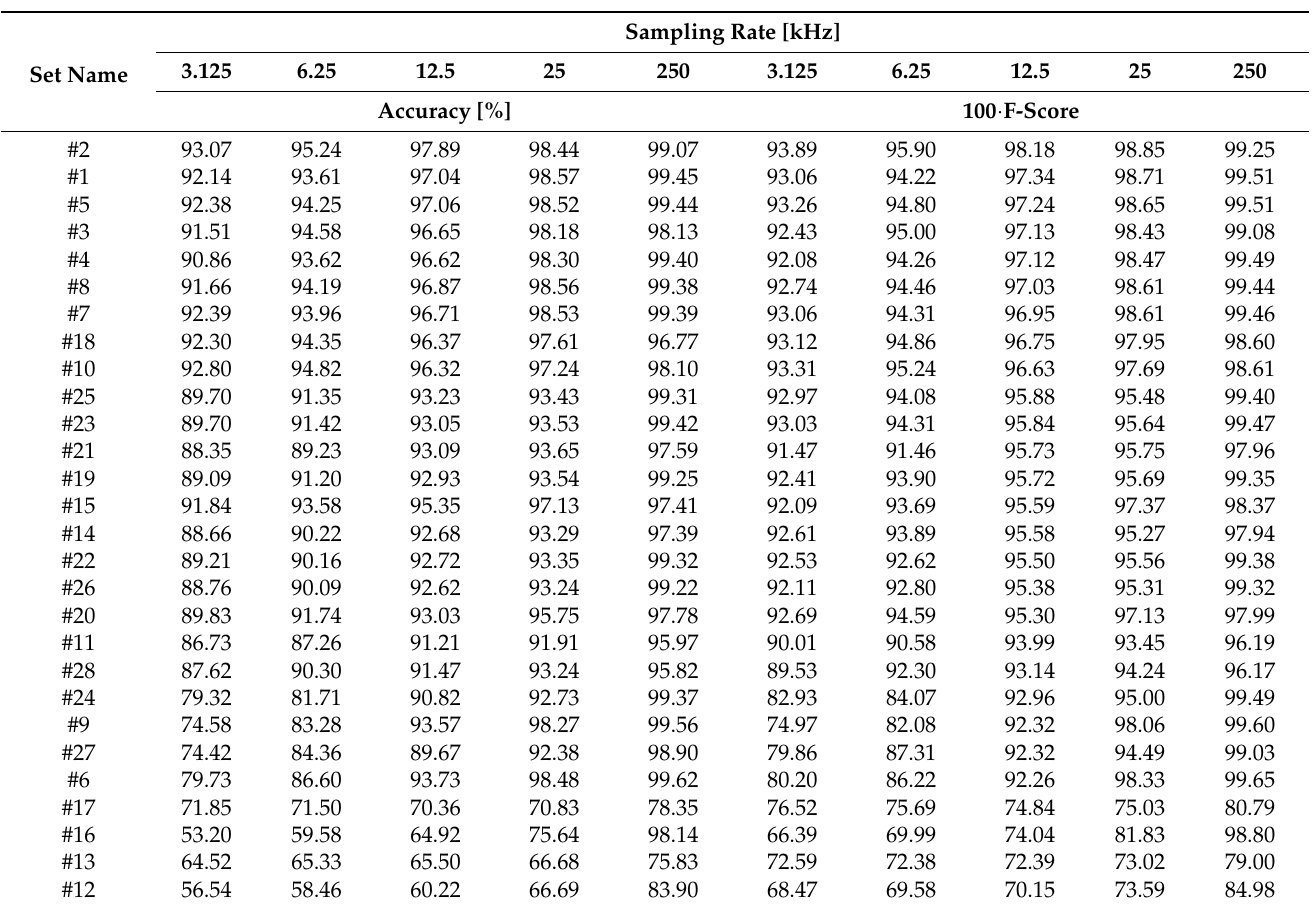
Table 5. Arc fault detection results for analysis in terms of IEC 62606:2013 standard, sorted by F- score for 12.5 kHz sampling